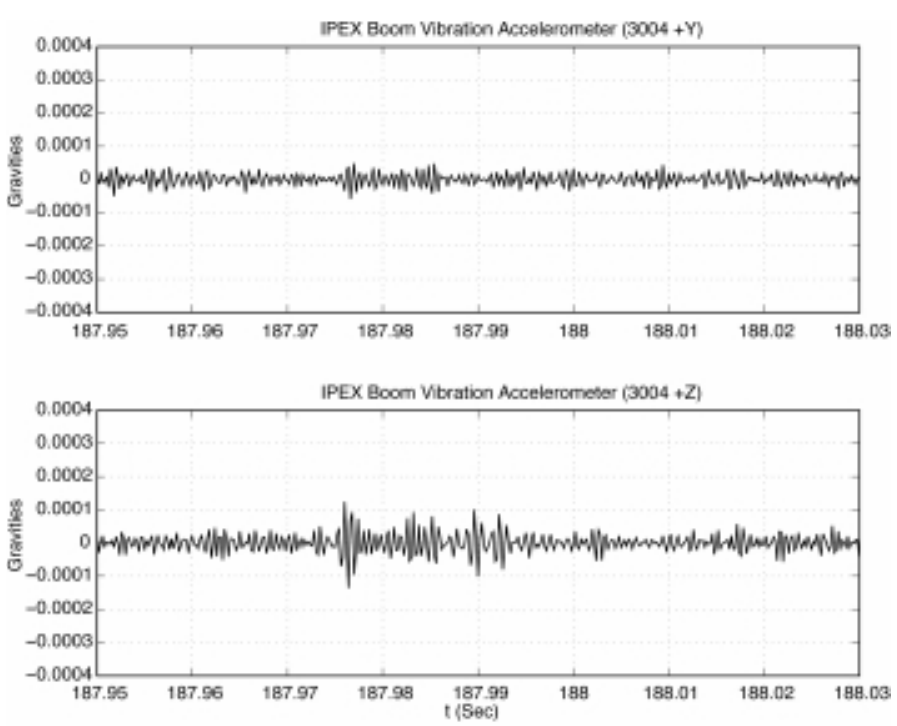
Fig. A9. Event 3 Node